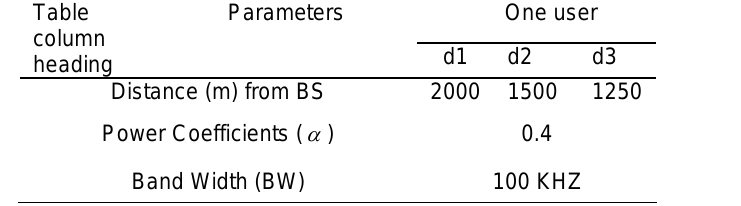
Table 2. Parameters utilized for the second scenario Table column